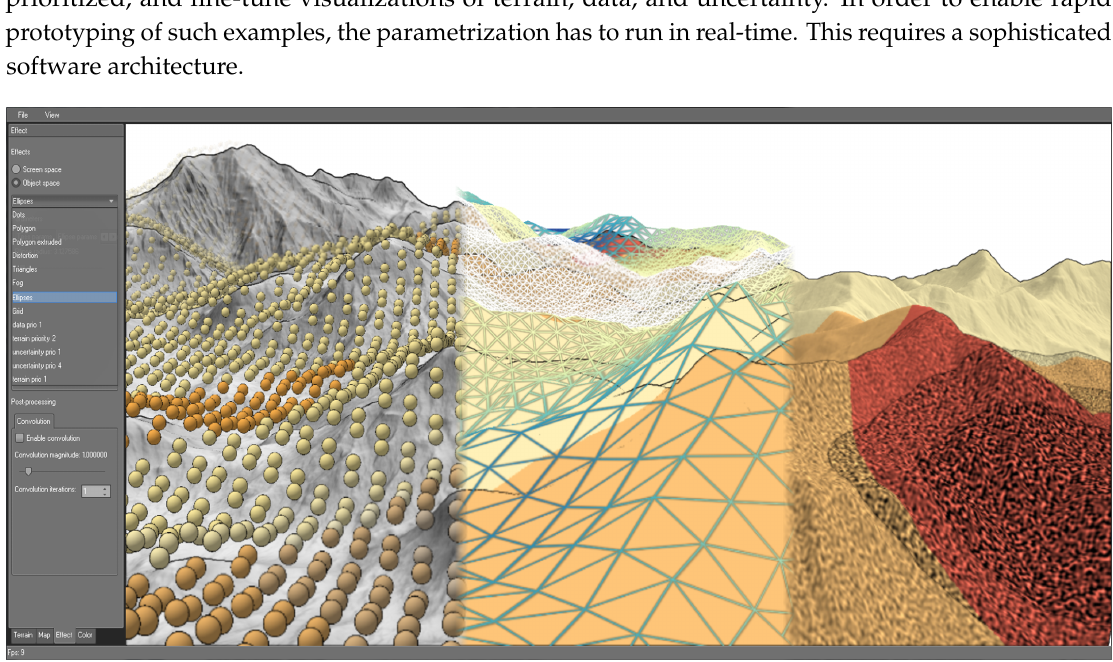
Figure 10. Interactively selecting different visual encodings for uncertainty. The graphical user interface of P RIO V IS allows for choosing from different visualization techniques, e.g., circular glyphs (left), grid overlays (middle) and noise (right), and tuning their parameters via GUI control